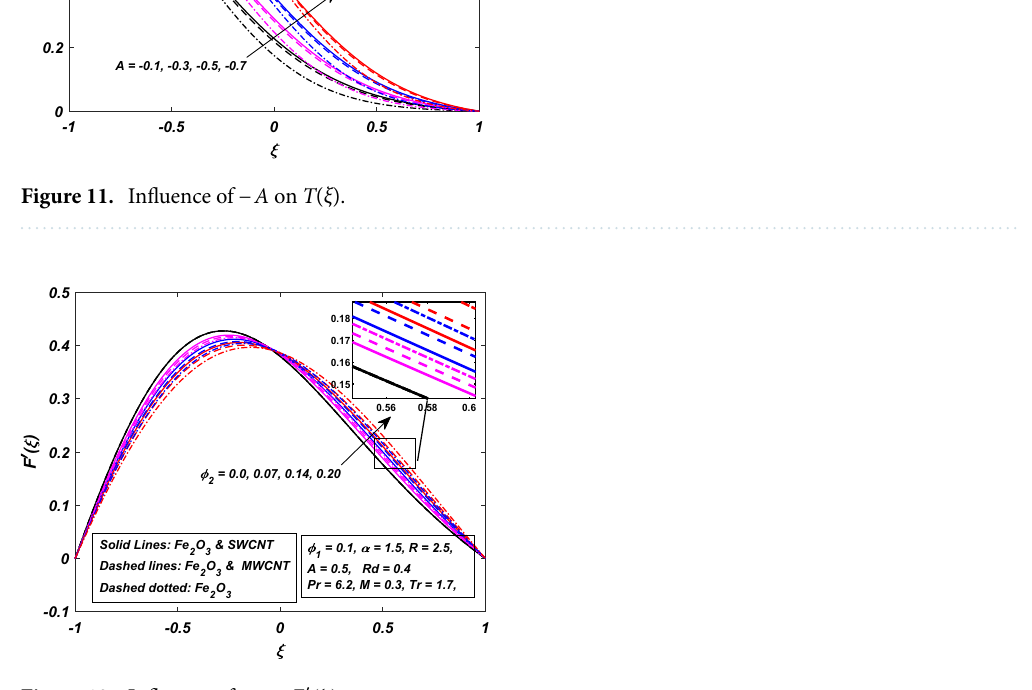
Figure 12. Influence of φ 2 on F ′ (ξ)